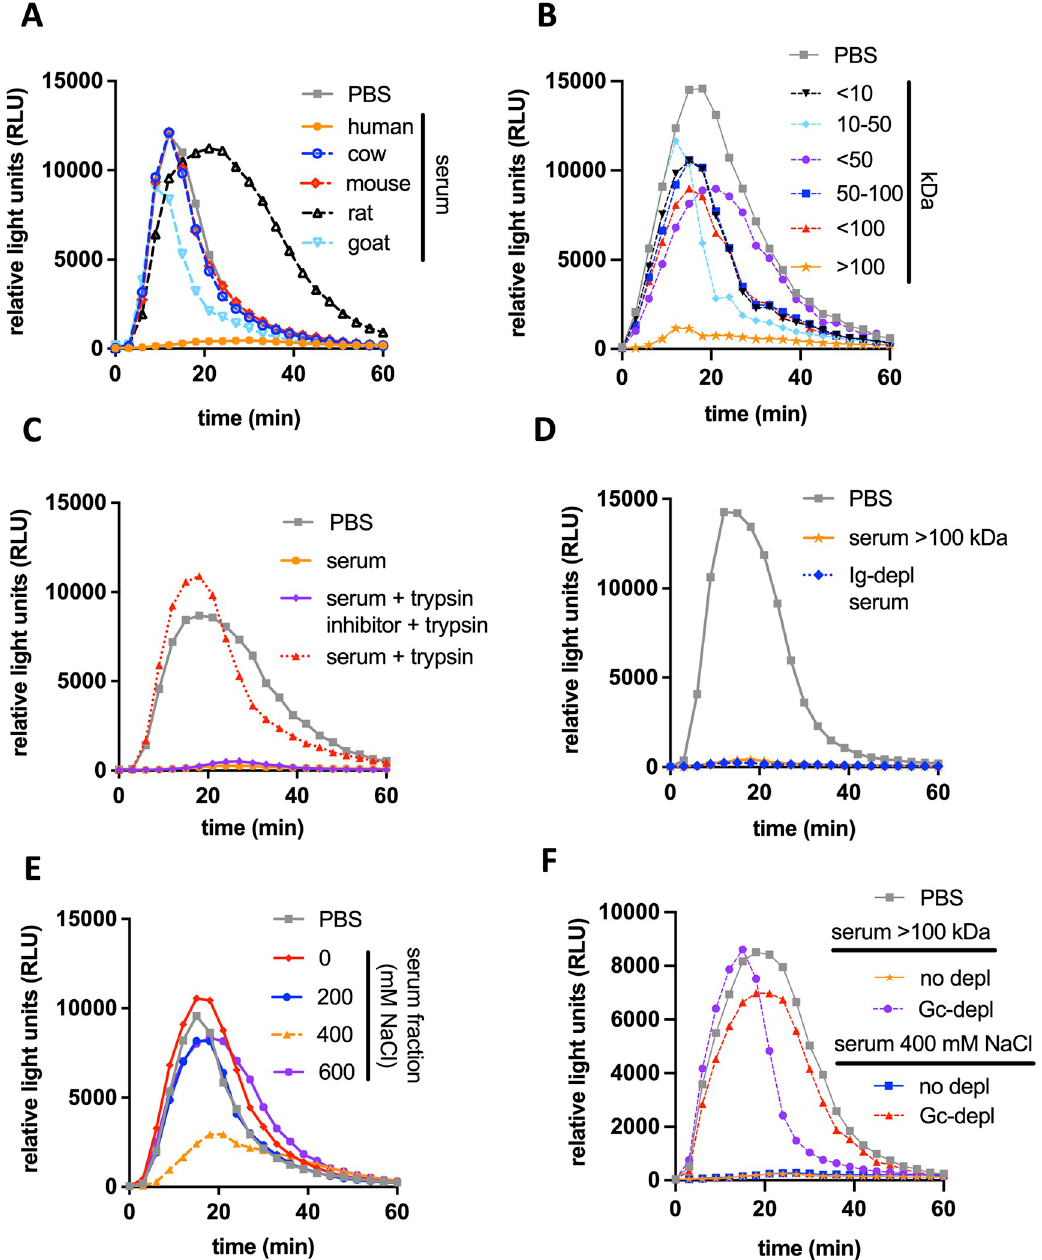
Fig 2. Characteristics of the serum component that suppresses Opa+ Gc induced neutrophil ROS. ( A-F) OpaD+ Gc were exposed to primary human neutrophils and ROS production was measured as in Fig 1C. Before addition to neutrophils, OpaD + Gc was incubated with serum from the indicated species (final concentration, 25%) (A); the indicated molecular weight fraction of human serum (B); human serum that was intact (solid orange; UVA), treated with trypsin (dotted red), or treated sequentially with trypsin inhibitor then trypsin (purple) (C); the � 100 kD human serum fraction from (B) (orange), or serum depleted of immunoglobulins G, M, and A (“Ig-depl serum”, dotted blue) (D); human serum fractions generated by anion exchange chromatography via elution with the indicated molarity of NaCl (E); or the indicated suppressive serum fraction from B and E that was pre-incubated with Gc (“Gc-depl”) or not (“no-depl”) (F). Incubation of OpaD+ Gc with PBS+ was used as a positive control for neutrophil ROS production in all conditions